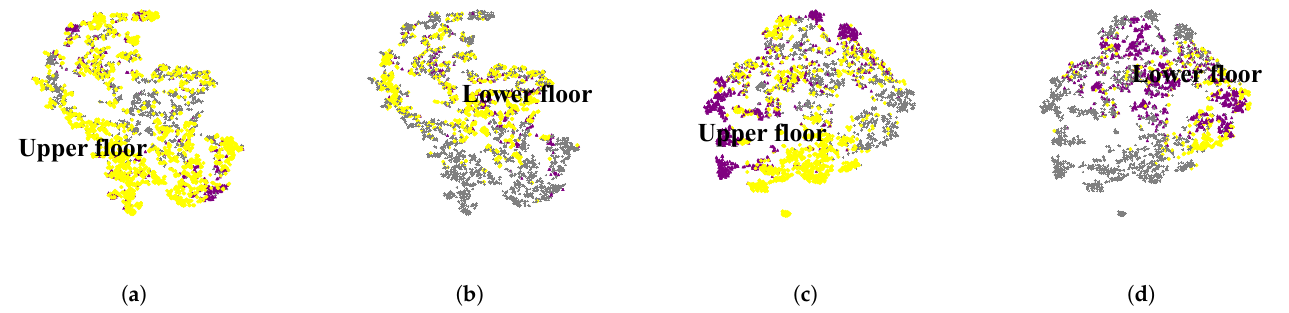
Figure 8. The symbols in purple and those in yellow represent t-SNE of learned and unlearned signals, respectively, for a single selected floor among floor above and below. In addition, those in gray represent the other floor. ( a , b ), respectively, colorize signals from the floor above and below in T p,APT II | APT 1 . ( c , d ), respectively, colorize signals from the floor above and below in T p,APT I | APT 2